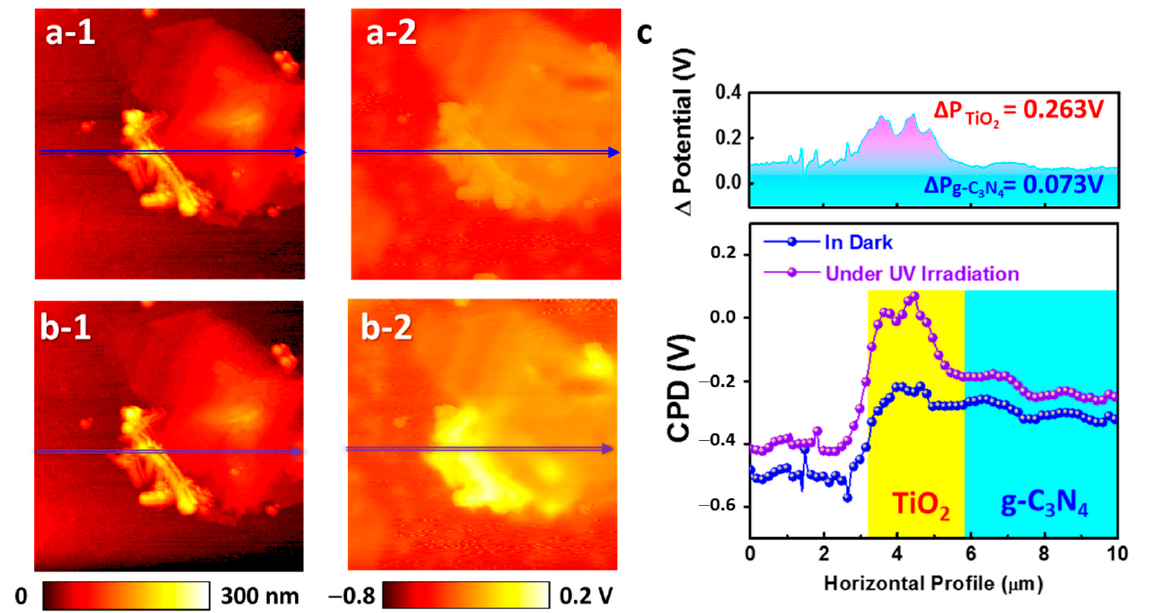
Figure 9. Topographic images of g-C 3 N 4 /TiO 2 catalyst ( a-1 ) in dark, and ( b-1 ) under UV irradiation; the surface potential images of g-C 3 N 4 /TiO 2 catalyst ( a-2 ) in dark, and ( b-2 ) under UV irradiation; ( c ) horizontal profile for the surface potential mapping of g-C 3 N 4 /TiO 2 catalyst, and related potential change (upper).